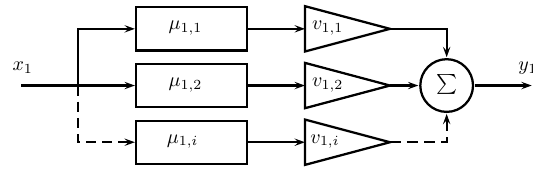
Figure 10. Configuration example for a partial